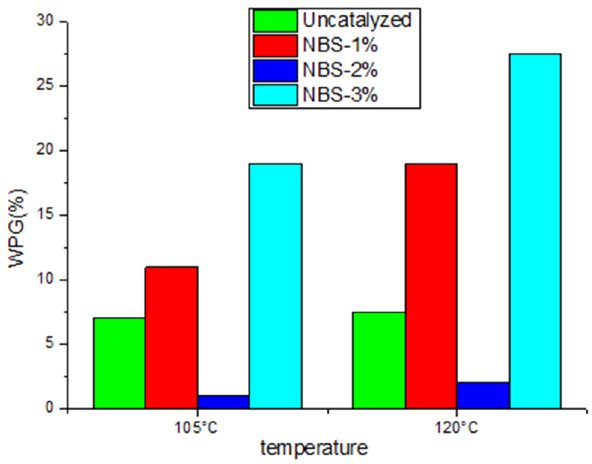
Figure 2: Comparison of the weight gain rate between untreated wood and wood treated with di ff erent concentrations of NBS solu - tion [ 35 ]